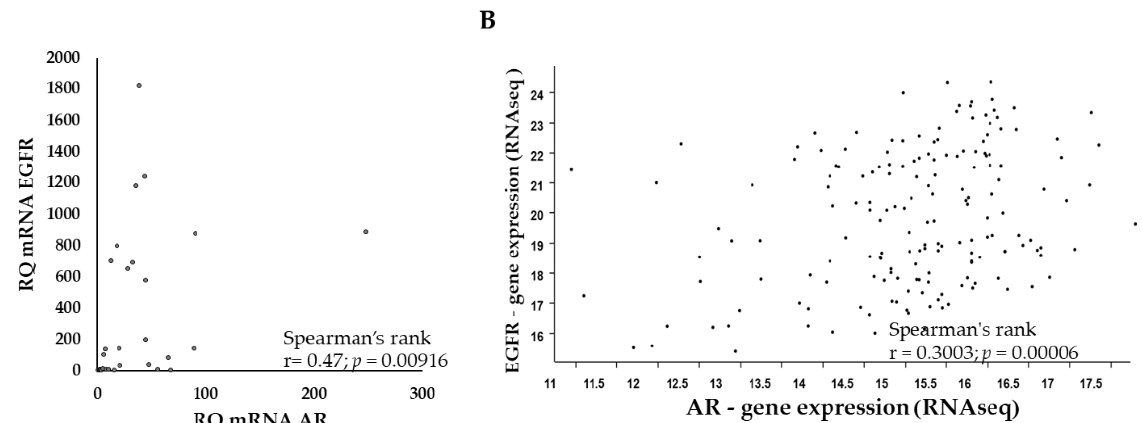
Figure 1. AR and EGFR expression levels are highly correlated in glioblastoma. ( A ) Spearman correlation analysis of qPCR results of AR versus EGFR mRNA expression following normalization to HPRT in 28 glioblastoma tumor samples. Y -axis, relative quantification (RQ) of EGFR; X -axis, the RQ of AR. ( B ) Spearman correlation analysis of AR and EGFR RNA sequencing (RNA-seq) results from glioblastoma samples ( n = 671) of the National Cancer Institute Genomic Data Commons TCGA following normalization by log2 [fragment per kilobase per million reads map (fpkm-uq + 1)]. Each dot on the graph represents one tumor sample.